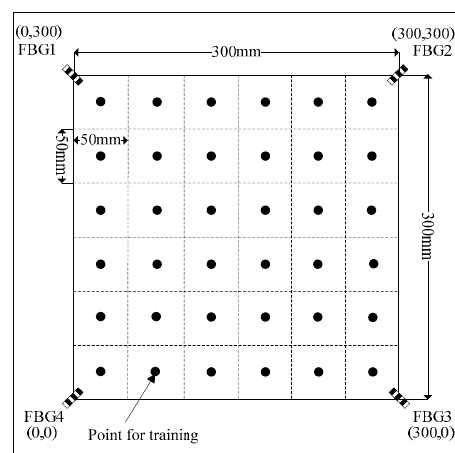
Fig. 1 FBG interrogation system.